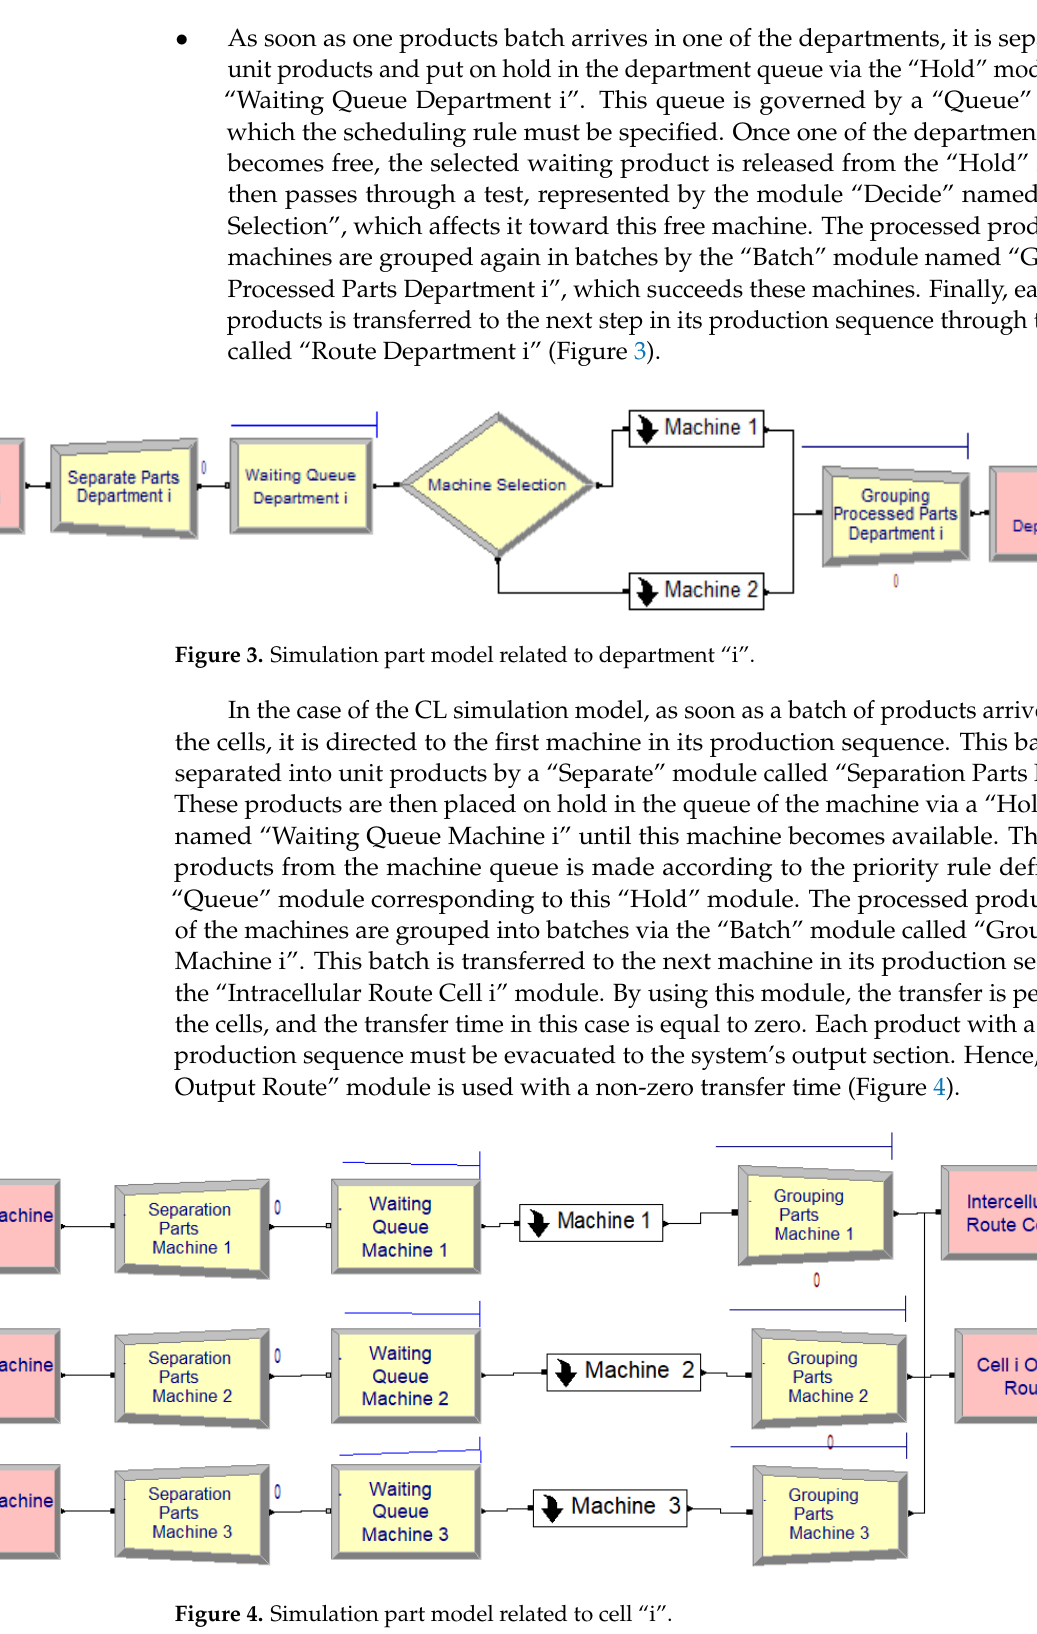
Figure 4. Simulation part model related to cell “i” .